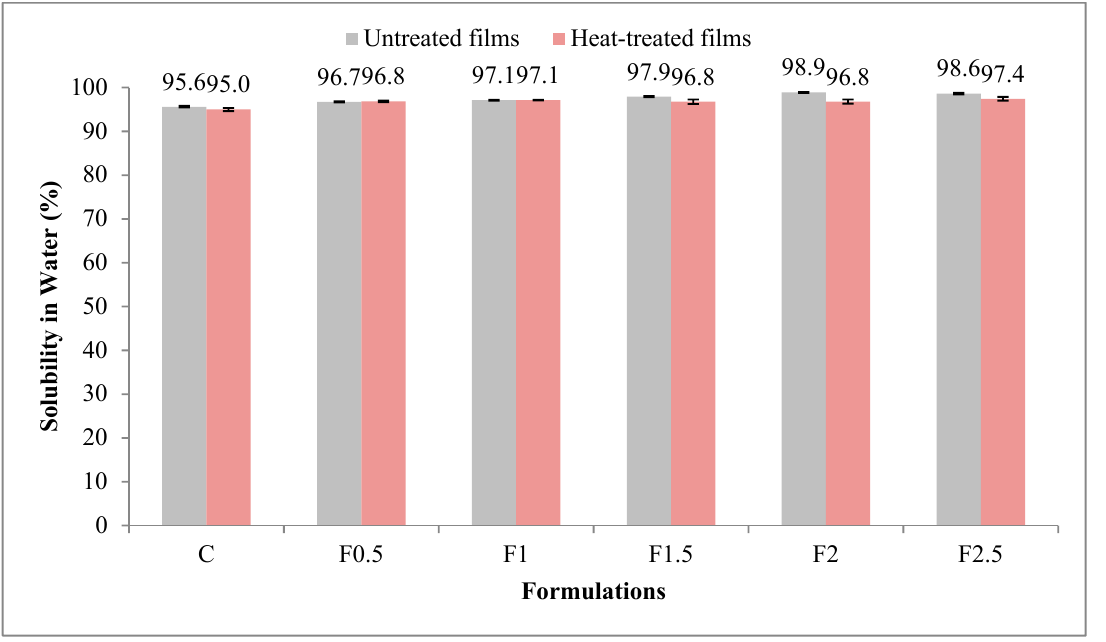
Figure 5. Variation of solubility in water with heat treatment and formulation. C-control film; F0.5-film with 0.5% tarragon essential oil; F1-film with 1% tarragon essential oil; F1.5-film with 1.5% tarragon essential oil; F2-film with 2% tarragon essential oil; F2.5-film with 2.5% tarragon essential oil. Values are expressed as mean ± standard deviation of three replicates.